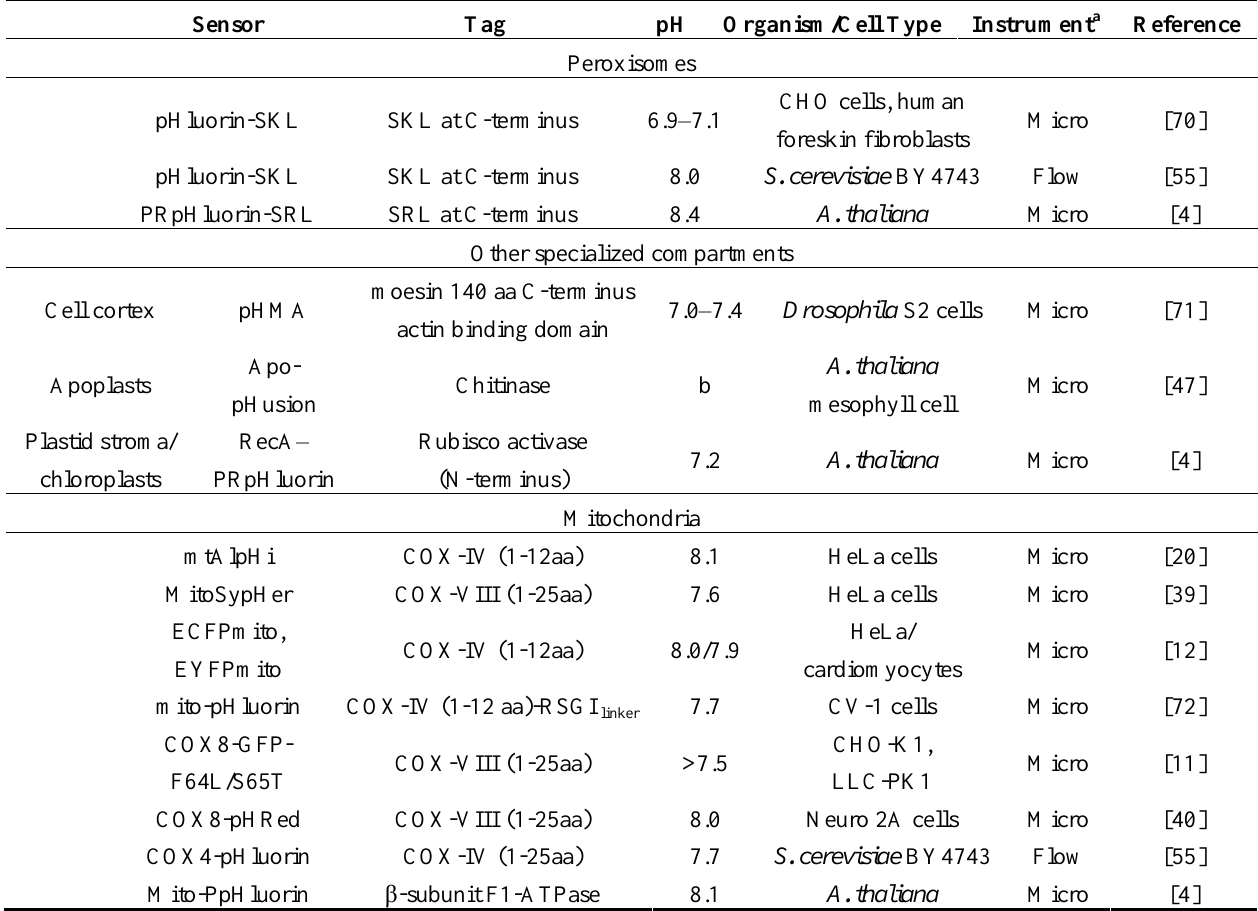
Table 7. Select examples of pH-sensitive FPs targeted to peroxisomes, mitochondria, and other specialized